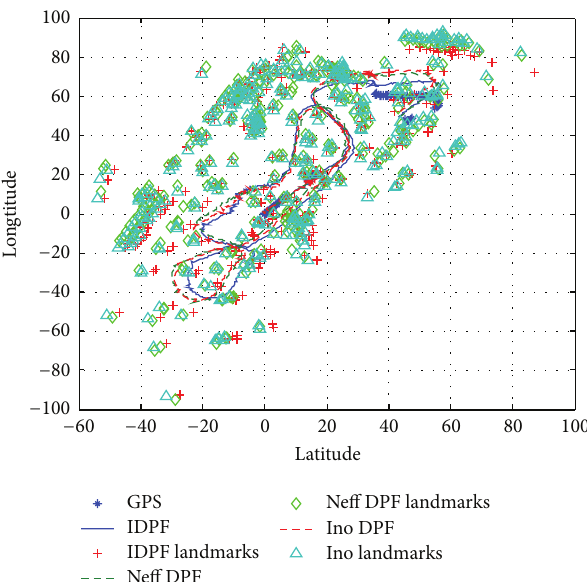
Figure 7: The comparison of estimation results in Experiment